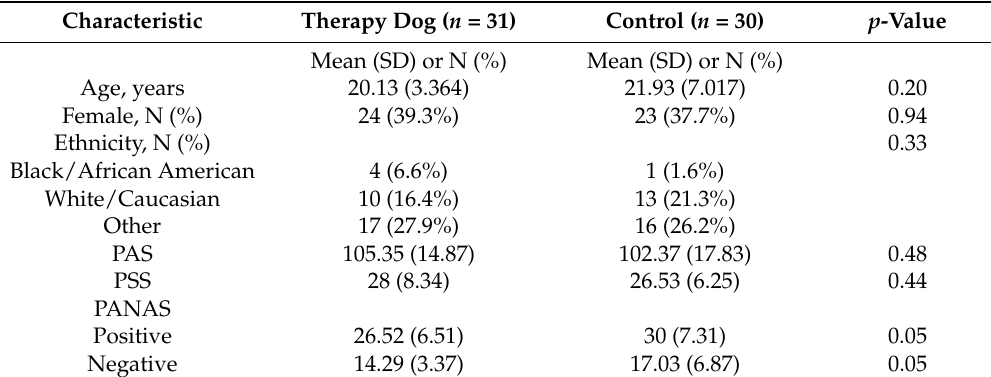
Table 1. Baseline characteristics of participants.